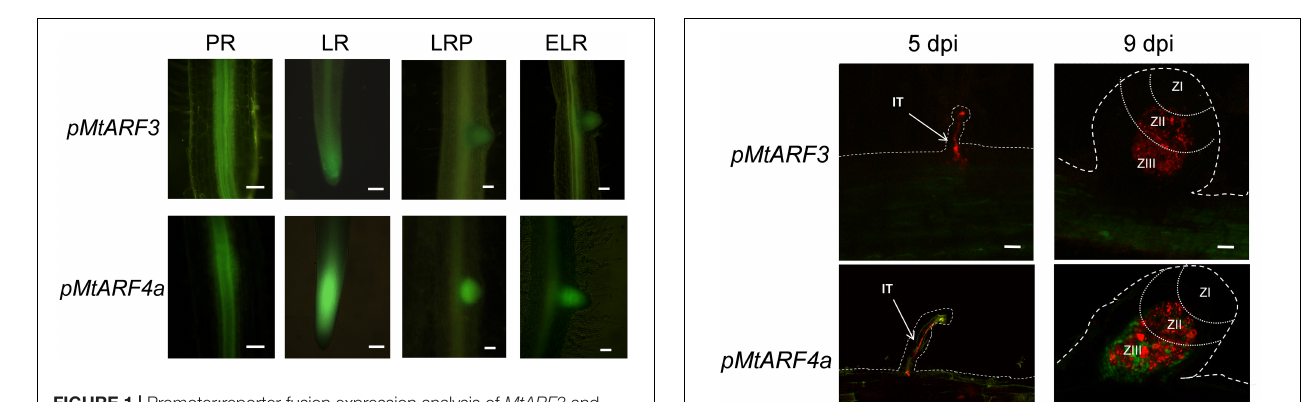
FIGURE 1 | Promoter:reporter fusion expression analysis of MtARF3 and MtARF4a in primary and lateral roots. Expression of the GFP reporter gene in roots transformed with the pMtARF3:GUS-GFP (upper panels) or the p MtARF4a:GUS-GFP (bottom panels) construct was detected in the vasculature of the primary root (PR) and lateral root (LR), in lateral root primordia (LRP) prior to emergence and in emerged lateral roots (ELR). Bars = 50 µ m.